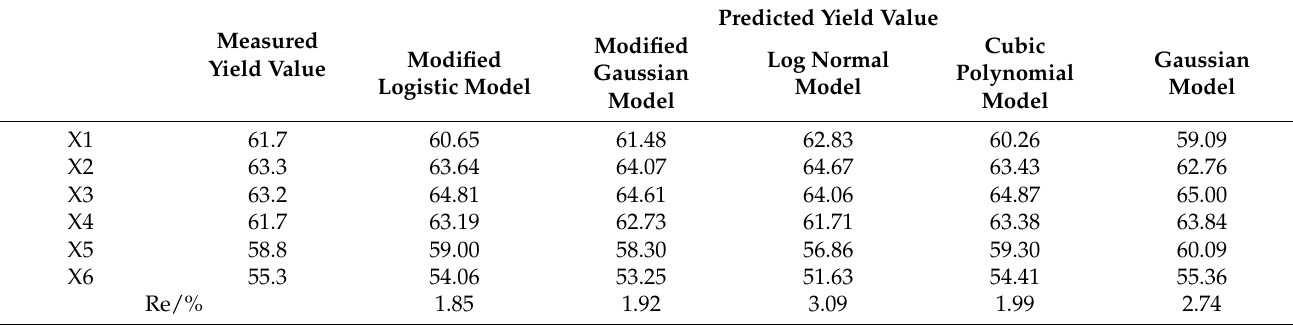
Table 5. Predicted grape yields and associated statistical parameters for the different models when used in conjunction with Equation (30). Re is the relative